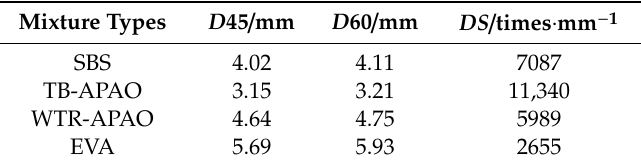
Table 5. Rutting test results of asphalt